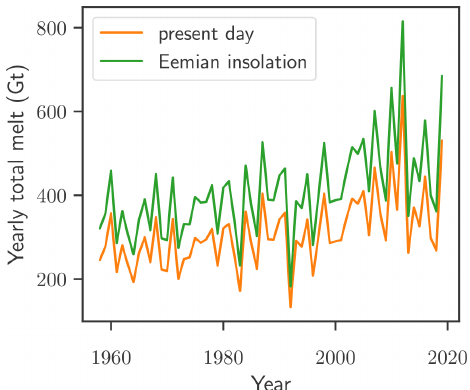
Figure 4. Comparison of Eemian vs. present-day insolation in dEBM-simple. Yearly total melt of the Greenland Ice Sheet as diag- nosed with PISM-dEBM-simple under present-day insolation (or- ange) and Eemian insolation (green). The diagnostic simulations with PISM were performed using monthly MAR 2D temperature fields as forcing and the parameterizations for shortwave downward radiation and albedo mentioned in the